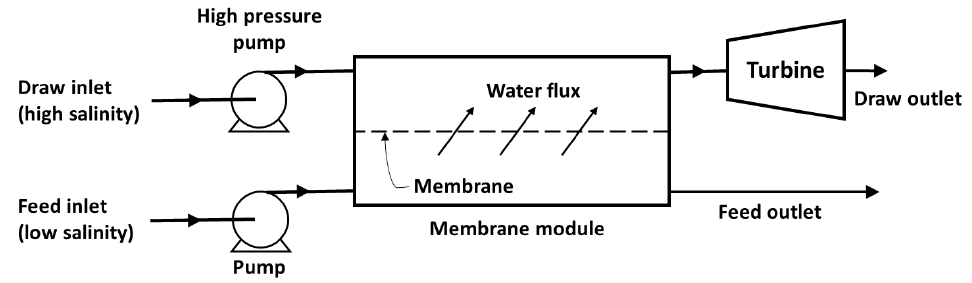
Figure 1. Schematic of a basic PRO process.